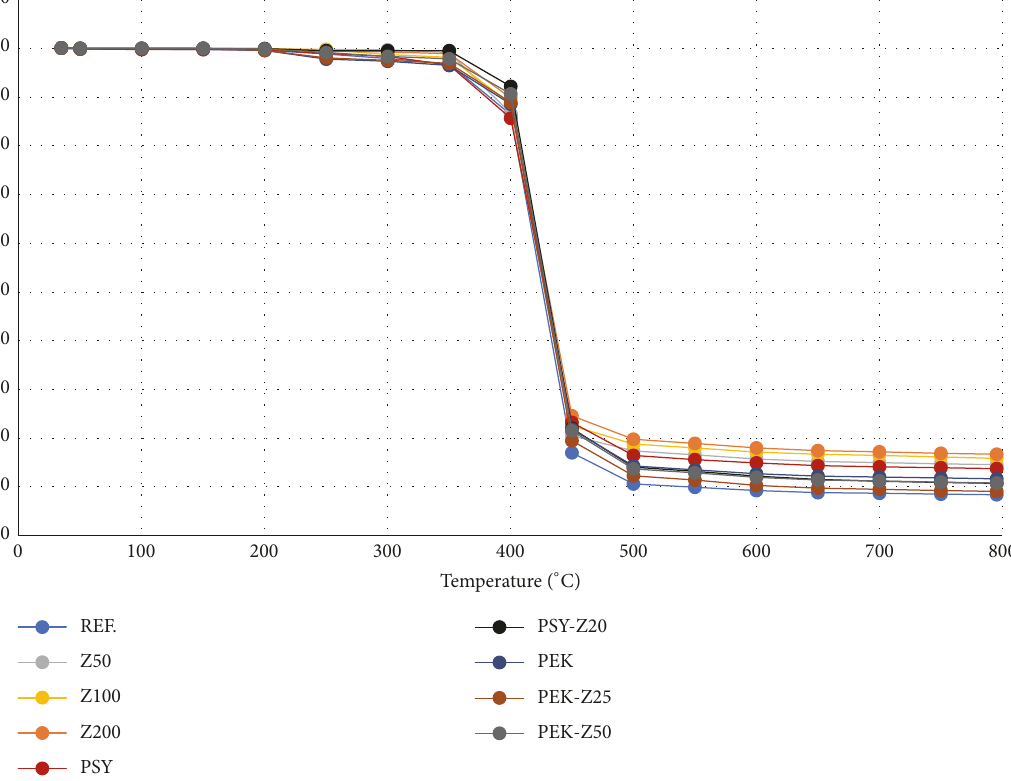
Figure 8: TGA curves of the samples.